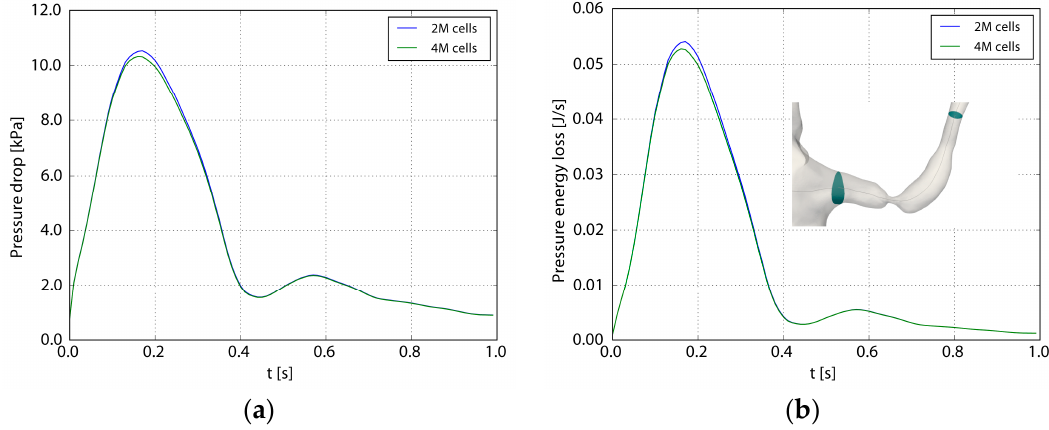
Figure 4. The pressure drop ( a ) and the losses ( b ) as functions of the flow. The pressure drop ( Δ p ) and the loss ( P ) are defined as ∆ p = 1 where A 1 and A 2 are the inlet and outlet planes to the renal artery depicted in the right frame. Two and four million computational cells were used in the two computations.